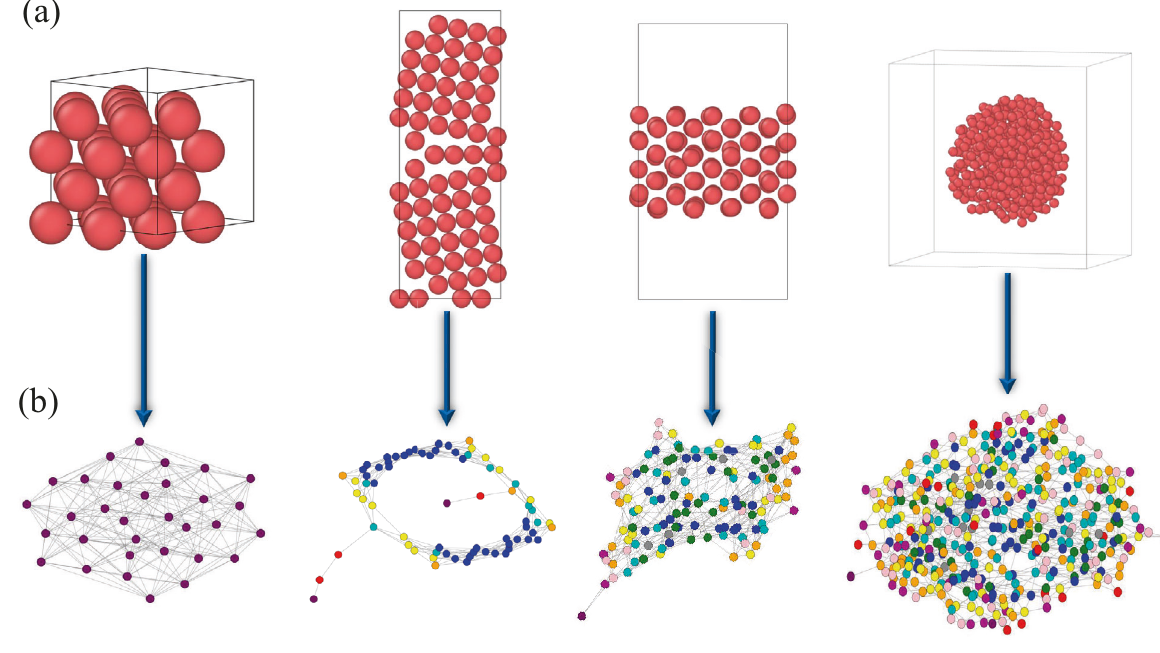
Fig. 6 Visual depiction of graph coordination networks for various Al structures. a Aluminum atomic con fi gurations from left to right: bulk FCC, ∑ (510) grain boundary, (110) surface, and a 12 Å diameter nanoparticle. b The corresponding graph coordination network at an R c of 3 Å. Vertices represent the atoms within their respective structures shown in ( a ), while the vertex colors represent the degree of the vertex. It should be noted that the colors are not universal, but are relative to the smallest vertex degree within the graph, with purple representing the smallest degree and with blue being indicative of the largest